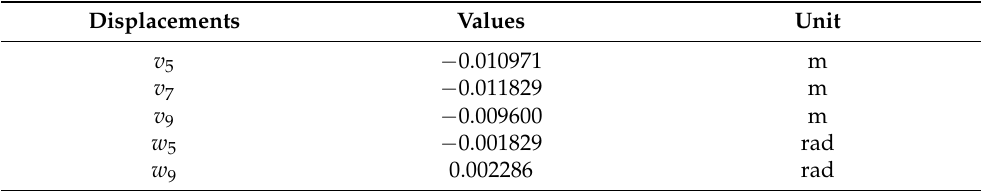
Table 1. Increments in displacements for example 1 due to the concentrated load V 5 = − 100 kN. Displacements